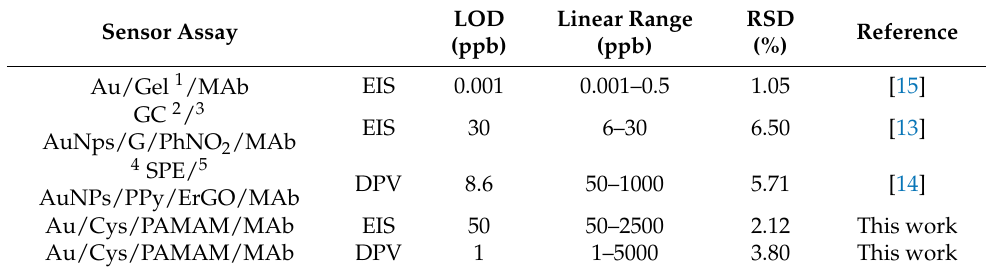
LOD Linear Range RSD Reference (ppb) (ppb) (%)